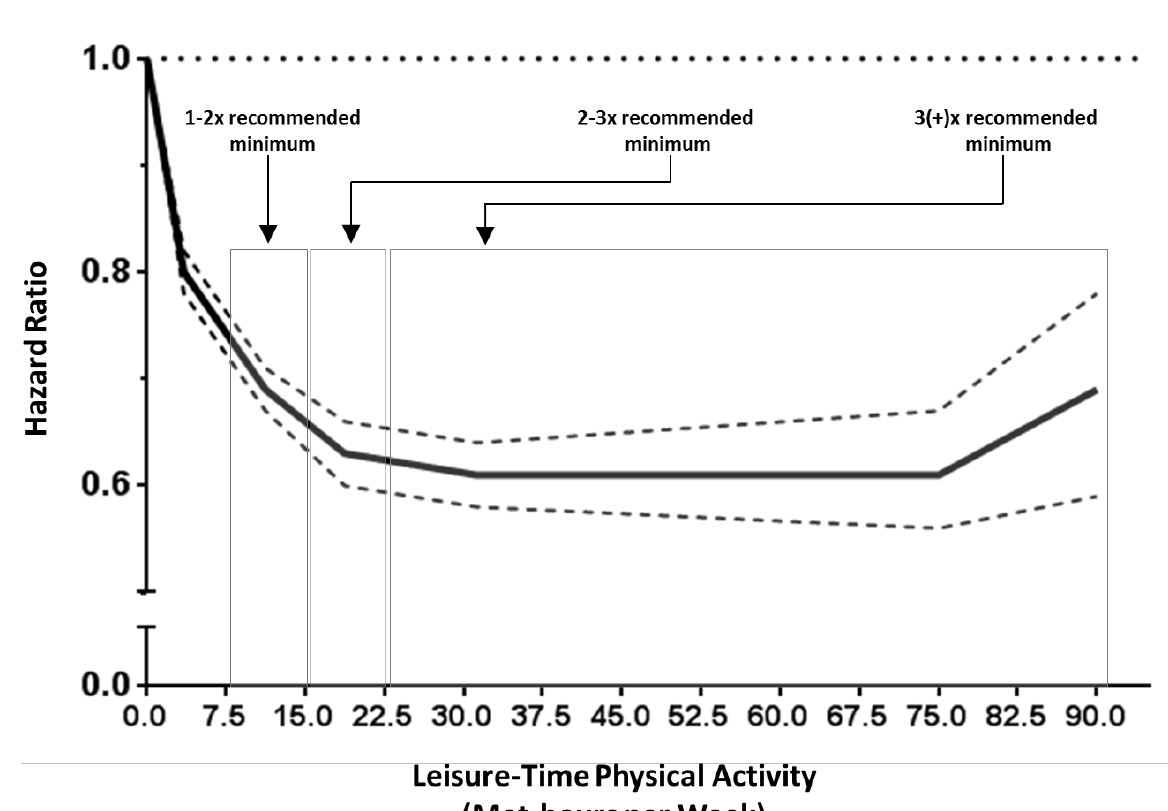
Figure F6-3. Relationships of Moderate-to-Vigorous Physical Activity to All-Cause Mortality, with Highlighted Characteristics Common to Studies of this